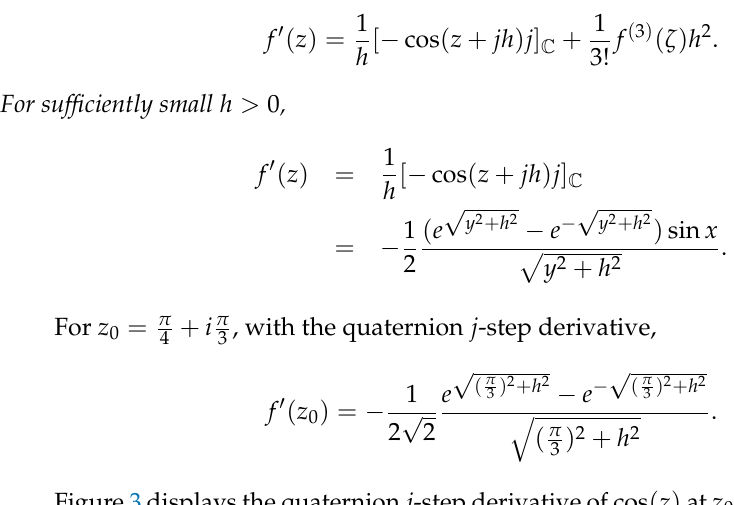
. It confirms to us how close the relative 2